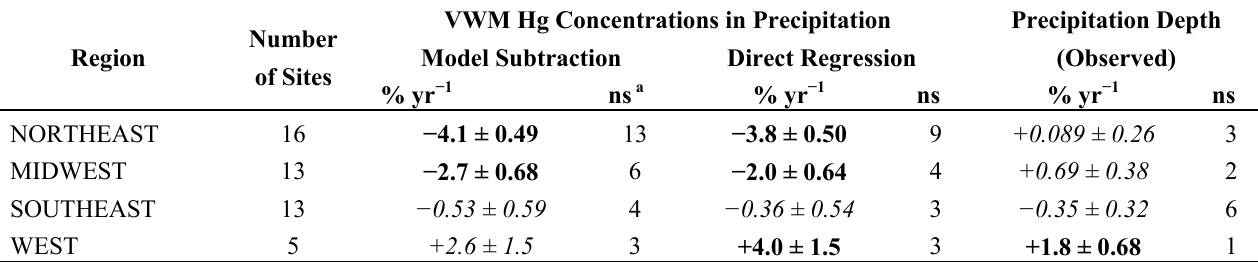
Table 2. Regional trends in VWM Hg concentration and precipitation depth. VWM Hg Concentrations in Precipitation Precipitation Depth Number Region (Observed) Model Subtraction Direct Regression of Sites % yr − 1 ns a % yr − 1 ns % yr − 1 ns NORTHEAST 16 − 4.1 ± 0.49 13 − 3.8 ± 0.50 9 +0.089 ± 0.26 3 MIDWEST 13 − 2.7 ± 0.68 6 − 2.0 ± 0.64 4 +0.69 ± 0.38 2 SOUTHEAST 13 − 0.53 ± 0.59 4 − 0.36 ± 0.54 3 − 0.35 ± 0.32 6 WEST 5 +2.6 ± 1.5 3 +4.0 ± 1.5 3 +1.8 ± 0.68 1 Significant trends ( p < 0.05) are indicated in bold fonts, trends that are insignificant are indicated in italics;